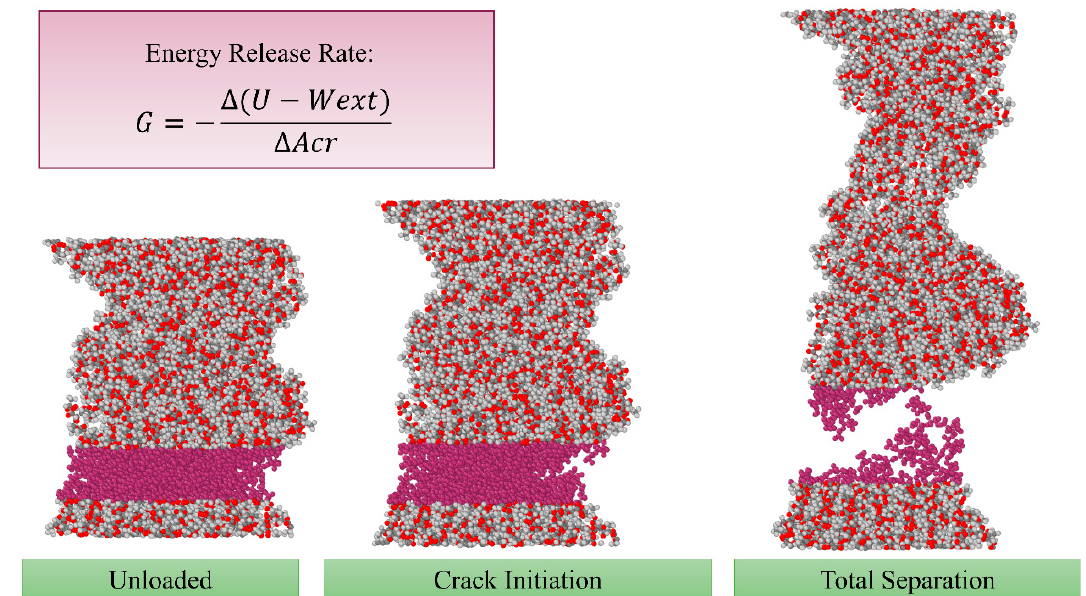
Figure 8. Determination of energy release rate for